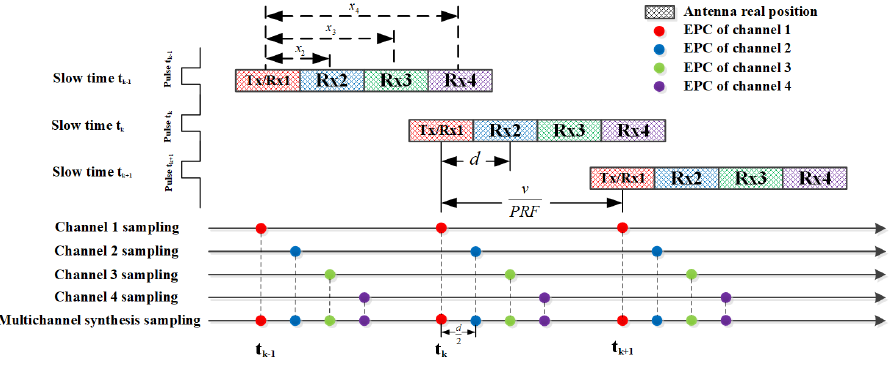
Figure 2. The azimuth sampling pattern for the four-channel SAR